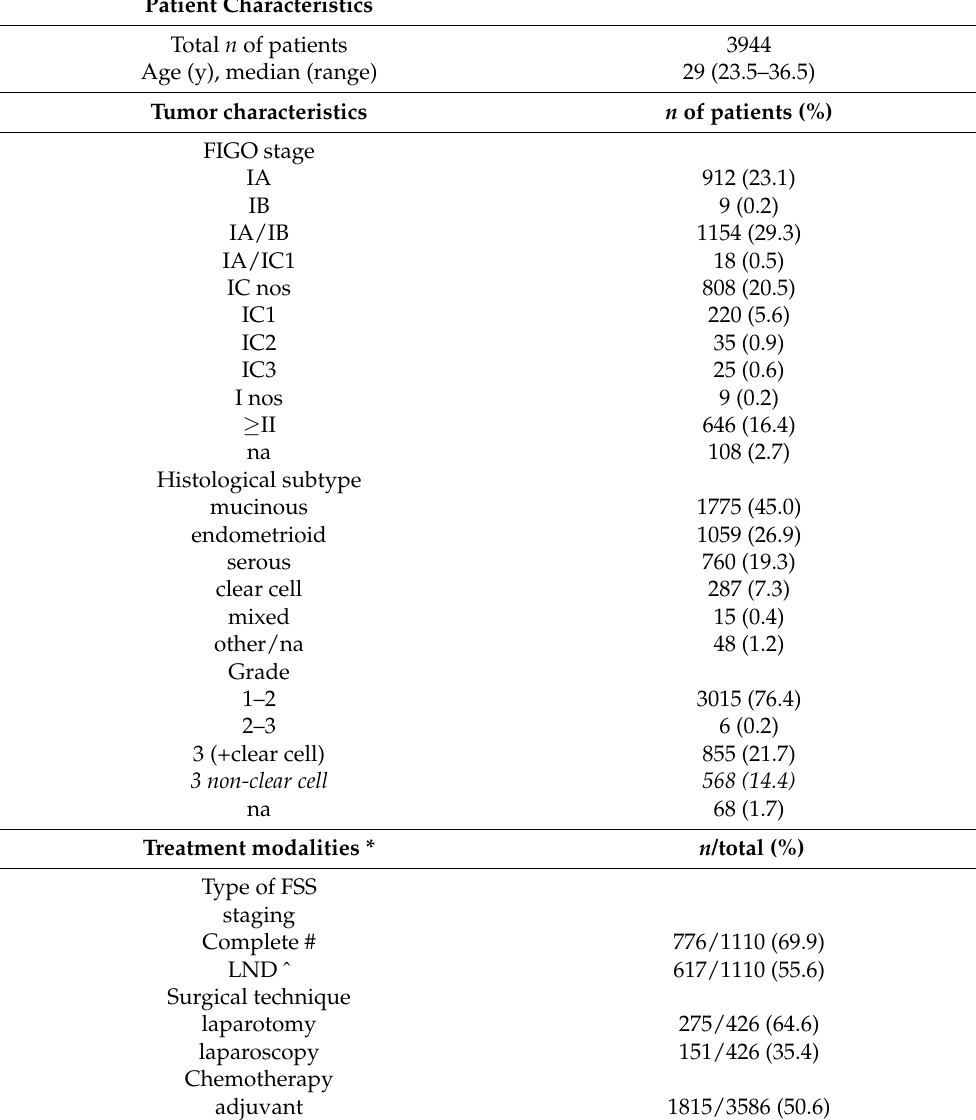
Table 2. Main characteristics and treatment modalities of patients with epithelial ovarian cancer undergoing